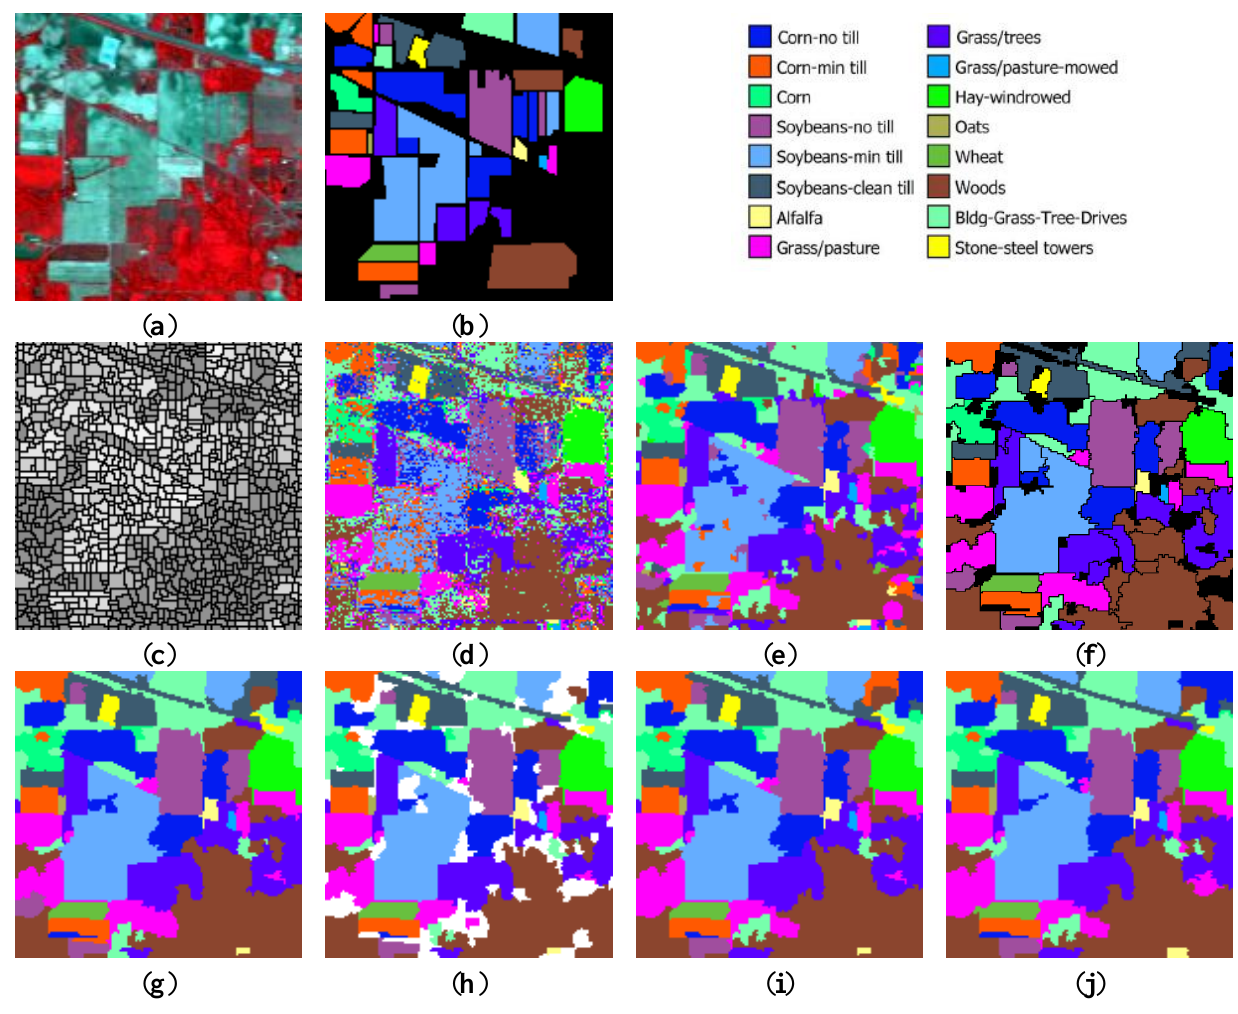
Figure 8. Indiana image: ( a ) three-band false color composite, ( b ) reference sites, ( c ) watershed segmentation map, ( d ) classification map by SVM, ( e ) initial segmentation via CC labeling, ( f ) segmentation map after GeneSIS (black areas denote the yet uncovered small regions of the image), ( g ) final classification map, ( h ) total agreement map after 30 runs, ( i ) classification map after FMV-fusion, and ( j ) classification map after MSF-based